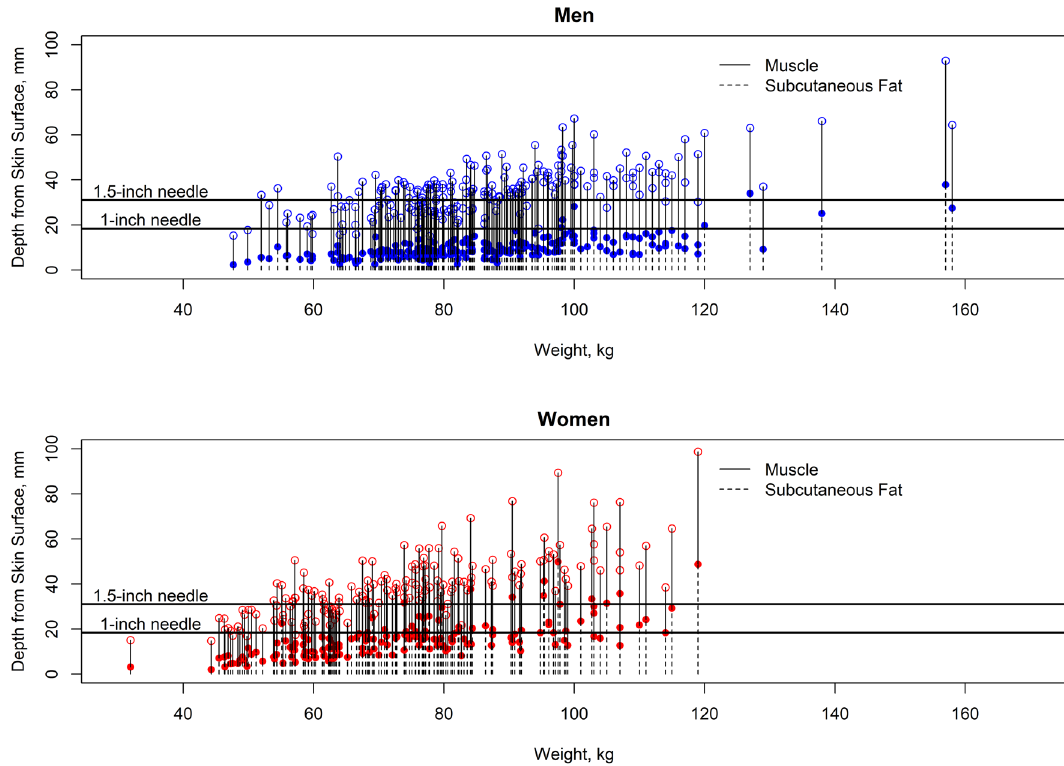
Figure 2. Plots of the deltoid subcutaneous fat and muscle thickness in men and women versus weight in kg. Weight in kilograms for each male (top) and female (bottom) individual, with CT measurements of depth from skin surface (0 mm) to bone. The skin-to-muscle distance (which defines the deltoid subcutanous fat pad thickness) is represented by dotted lines ending in a solid circle, while the muscle-to-bone distances (which defined muscle thickness) is represented by solid lines ending in an open square. Bone is represented by the area above the open circles. Blue filled circles – Distance from skin surface to the deltoid muscle surface in men. Blue unfilled circles – Distance from the skin surface to the humerus in men. Red filled circles – Distance from skin surface to the deltoid muscle surface in women. Red unfilled circles – Distance from the skin surface to the humerus in women. Horizontal black lines represent the effective maximum penetration depth of 1-inch and 1.5-inch